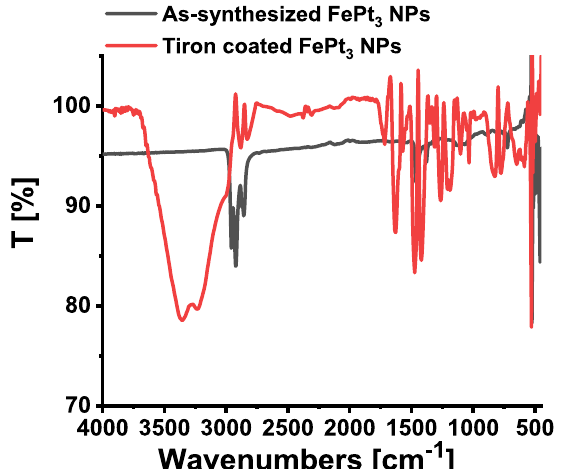
3 NPs (red solid line) 3